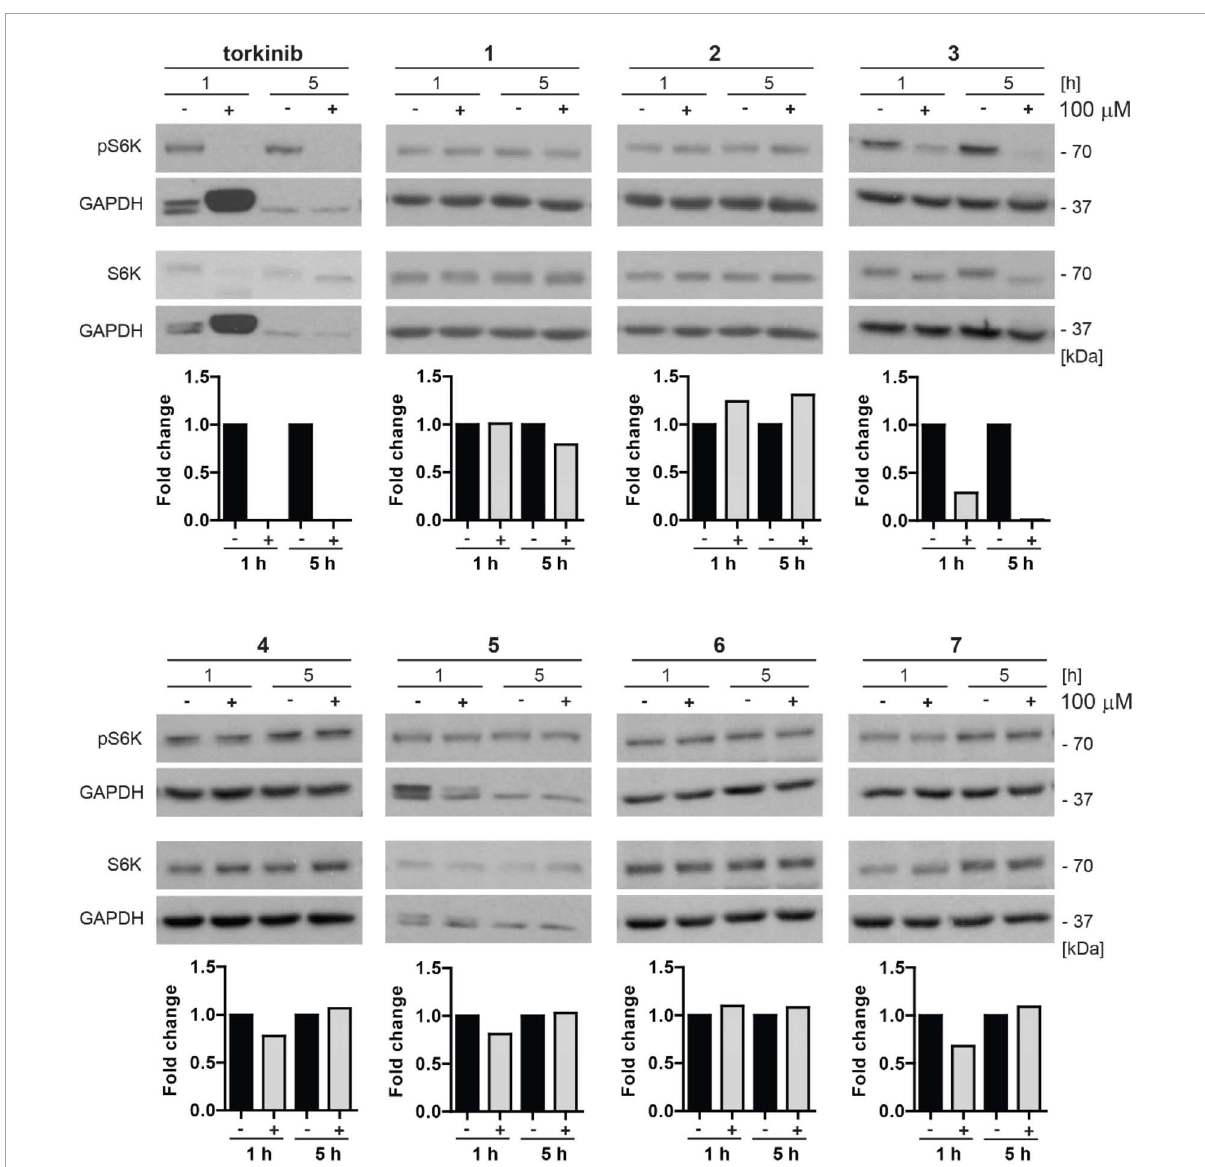
FIGURE8 Inhibitory effect of new compounds on mTORC1 kinase substrate p70 S6 kinase in BJ cells. All compounds ( 1 – 7 ) and control compound torkinib were tested at a concentration of 100 µ M for 1- and 5-h-long exposure. Whole-cell lysates were subjected to SDS-PAGE/immunoblotting analysis and probed for phospho-p70 S6K (Thr389) and total p70 S6K. GAPDH was used as a loading control. Note that the robustly elevated level of GAPDH after 1 h exposure to torkinib observed in all experimental replicates is not a loading